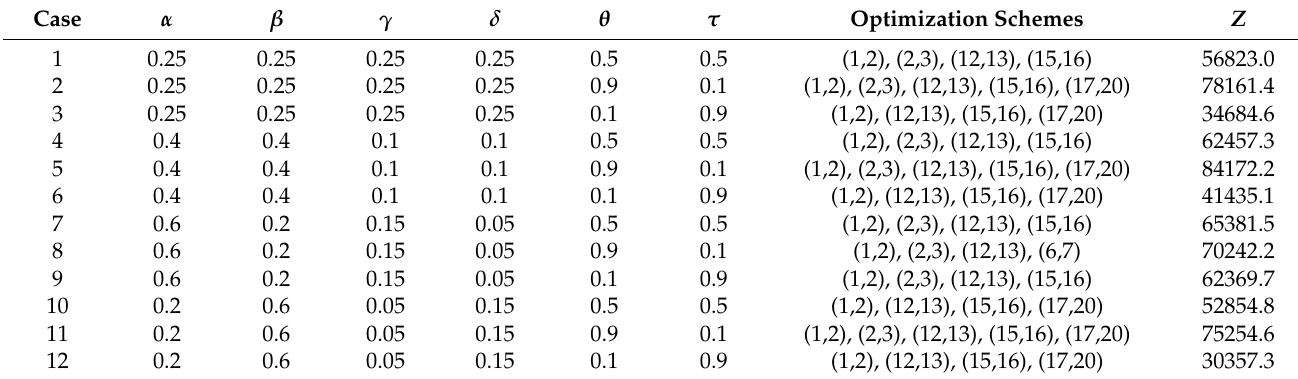
Table 9. Optimization results of the actual network under different weight